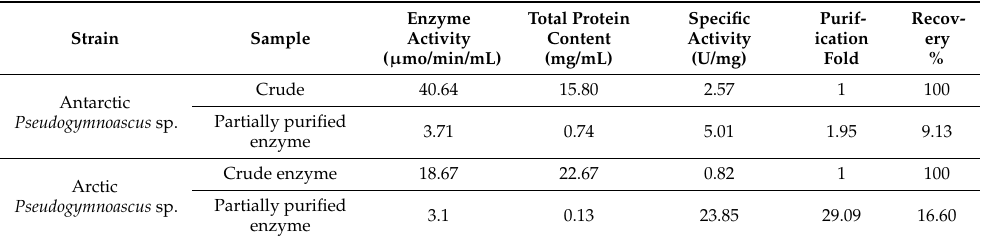
Enzyme Activity